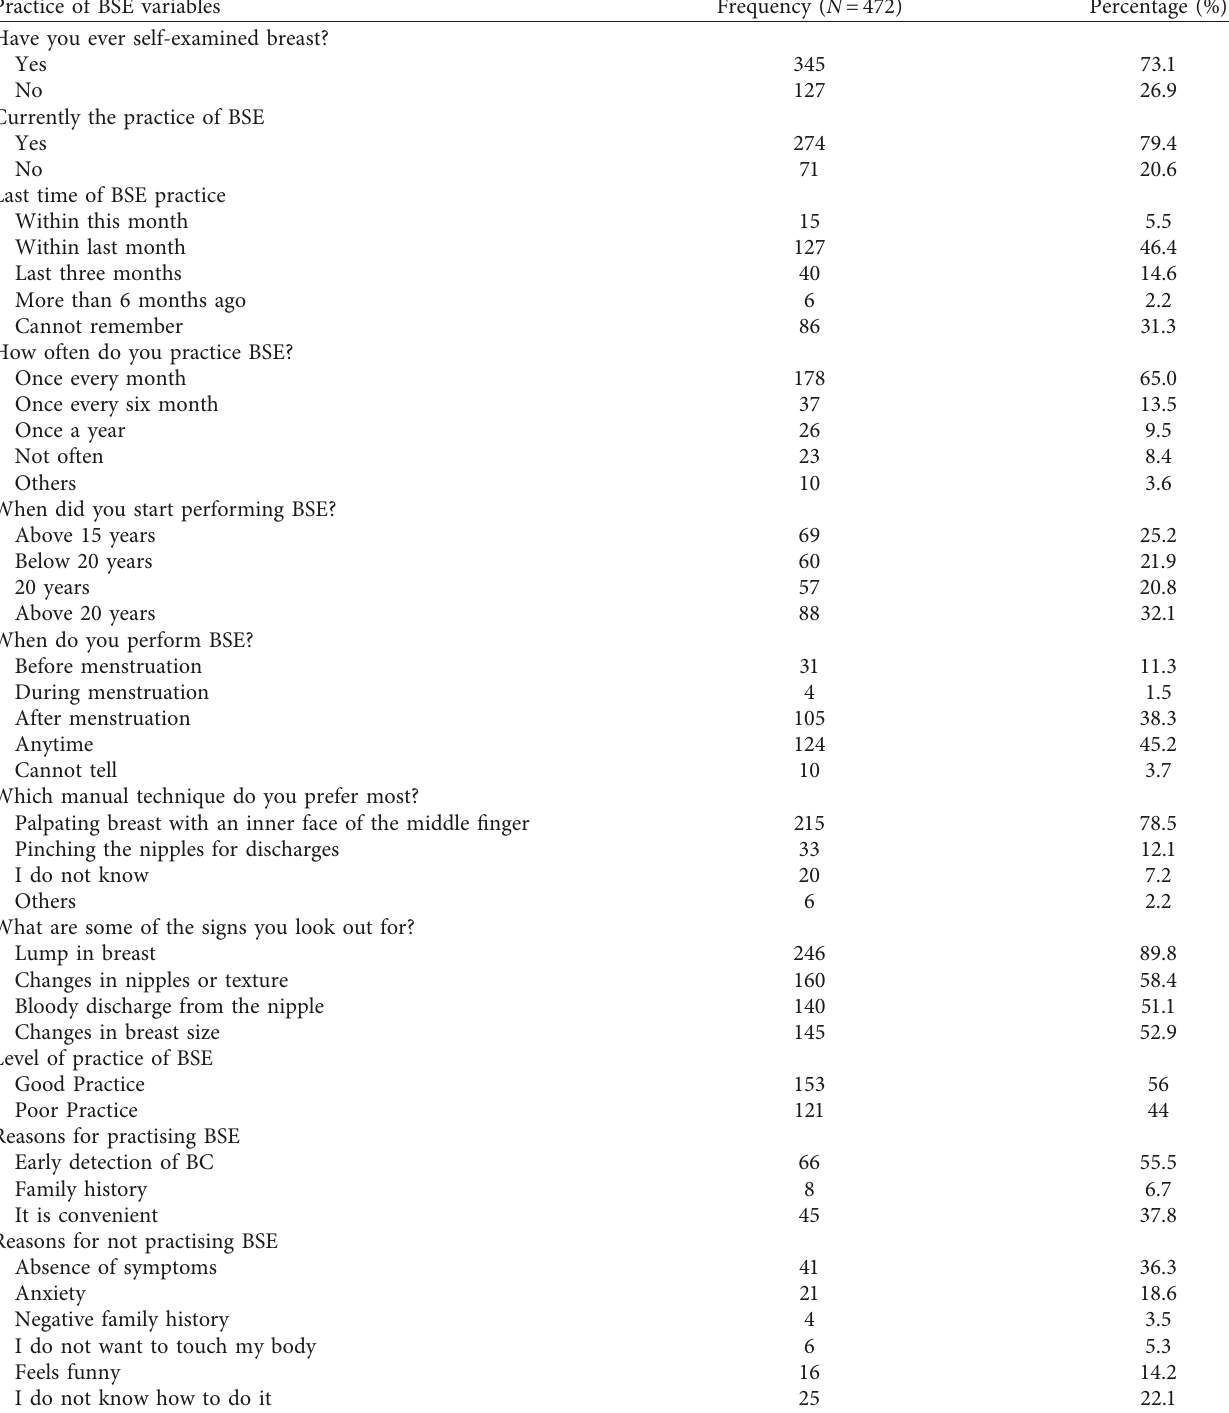
Table 2: Level of practice of breast